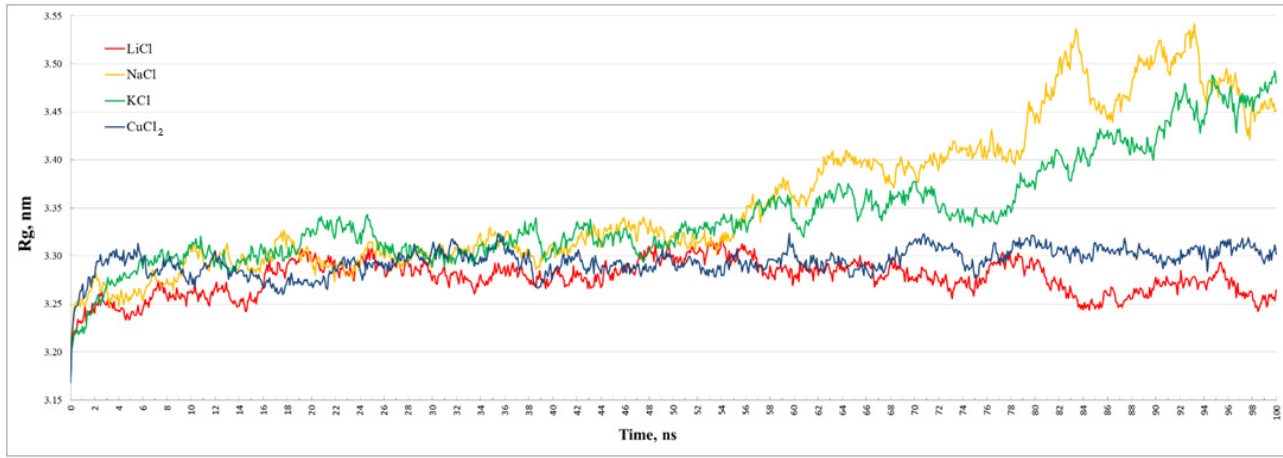
Figure 7. Radii of gyration of octamers (R g ) with different precipitants: LiCl, NaCl, KCl and CuCl 2 .